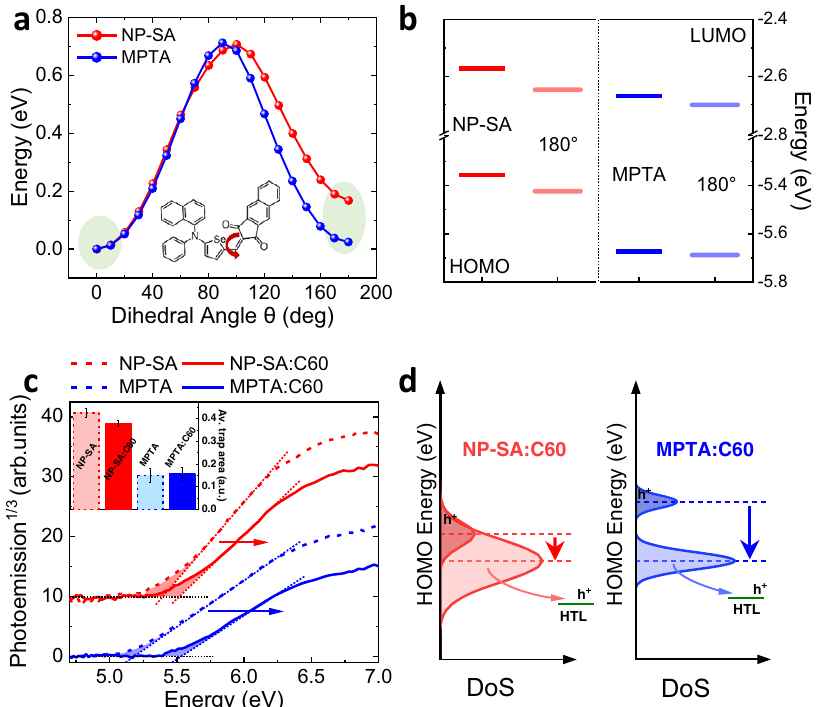
Fig. 5 Energetic analysis of NP-SA:C 60 and MPTA:C 60 blends. a The potential energy scan as a function of alkene bond dihedral angle between donor and acceptor units (e.g., as indicated for NP-SA in the inset), with highlighted the lower energy con fi guration at 0 and 180° dihedral angles for NP-SA and MPTA. b HOMO and LUMO energy levels for optimized geometries of NP-SA and MPTA and their isomeric forms, respectively with 0 and 180° D-A dihedral angle, calculated by DFT. c Photoemission spectra of neat and blended donors measured by APS, with the linear fi ts for the location of emission edge attributed to HOMO (dotted lines). The inset shows the density of tail states extracted from the integrated area below the HOMO onset, indicative of shallow trap density, with error bars as standard deviation across multiple measurements. d Distribution of deep and shallow trap states. MPTA:C 60 has a narrower shallow trap distribution and the presence of a deeper trap DOS. The trap states are fi lled by photogenerated holes from low energy states to high energy states gradually with the increase of light intensity. In low light, hole extraction from deep states of MPTA:C 60 is harder than the extraction from shallow states, due to the higher energy barrier, leading to hole trapping in deep